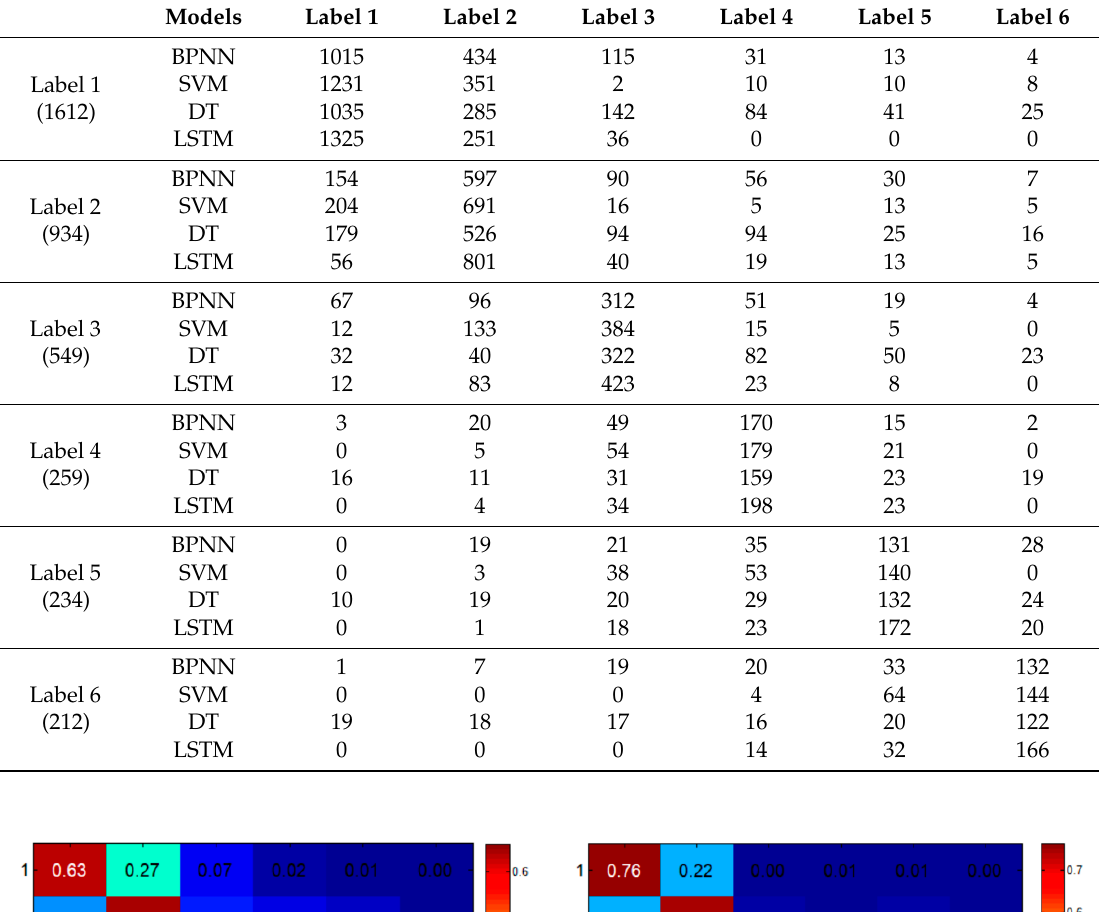
Table 2. Classification results of different models.